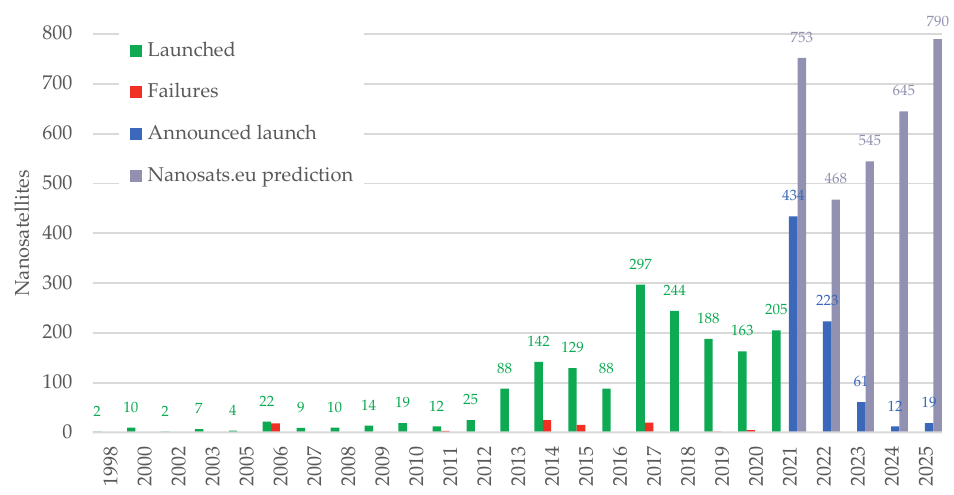
Fig. 1. Nanosatellite launches and forecasts. Table 1. ADCS configuration of some recently launched 1U academic CubeSat